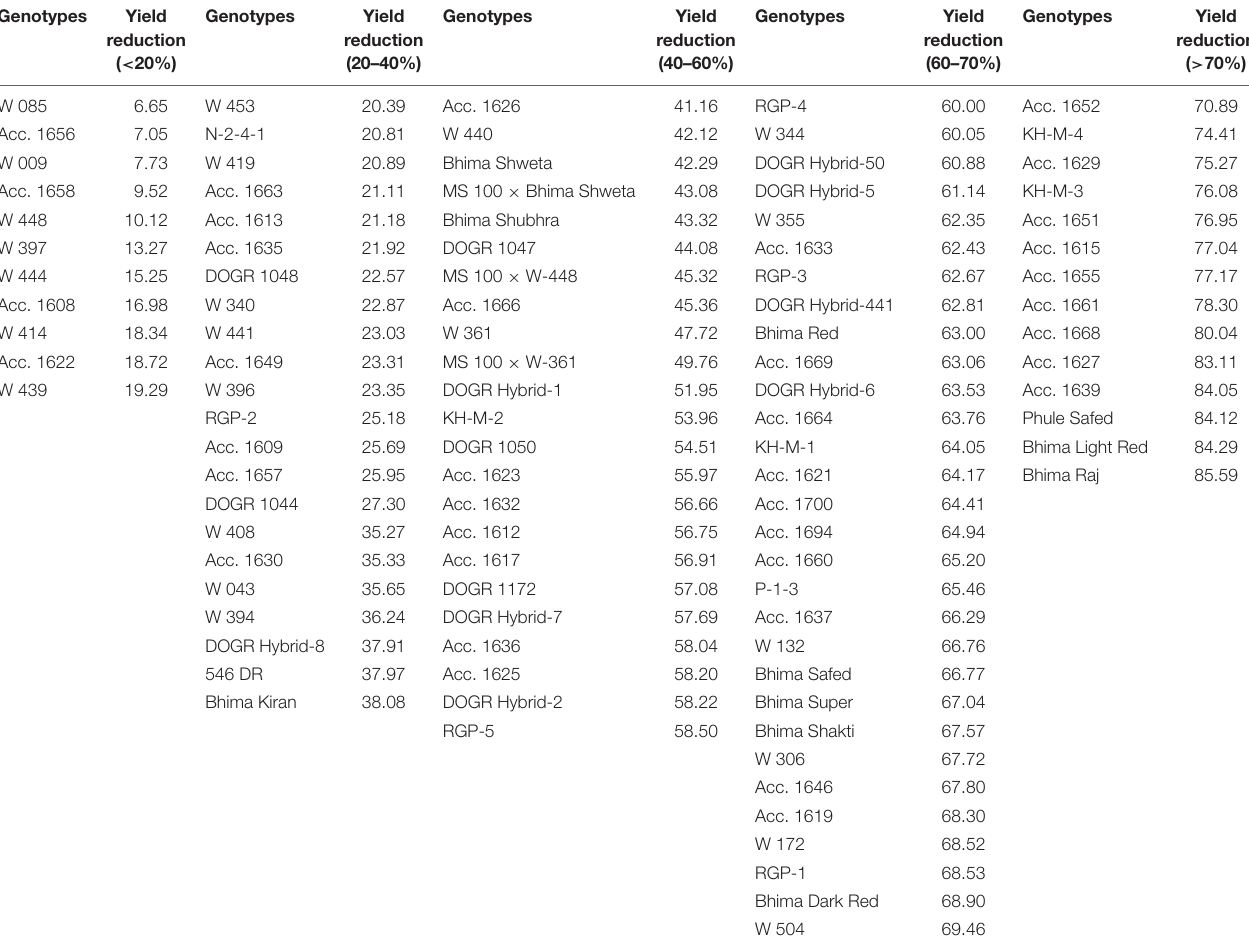
TABLE 1 | Genotypes grouped based on yield loss due to drought stress.